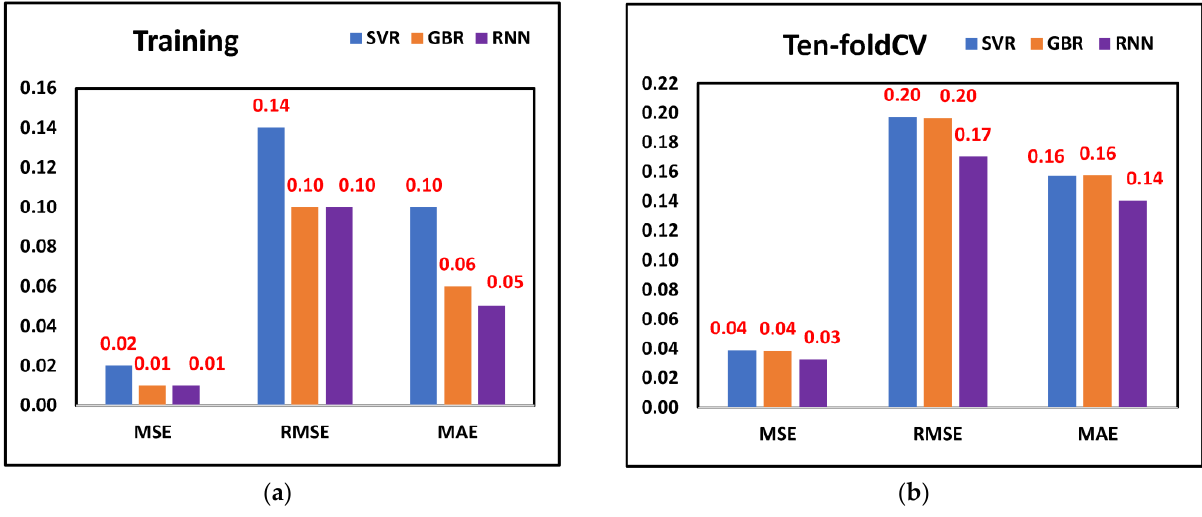
Figure 7. Prediction errors from Harris Hawk selected features ( a ) Training ( b ) Ten-fold.